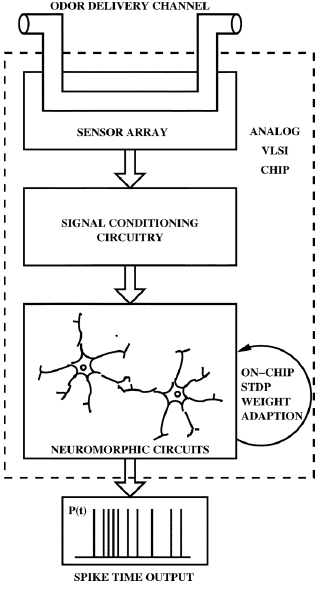
Figure 2. Block diagram of neuromorphic olfactory system proposed by Koickal et al. (Adapted from [16]).